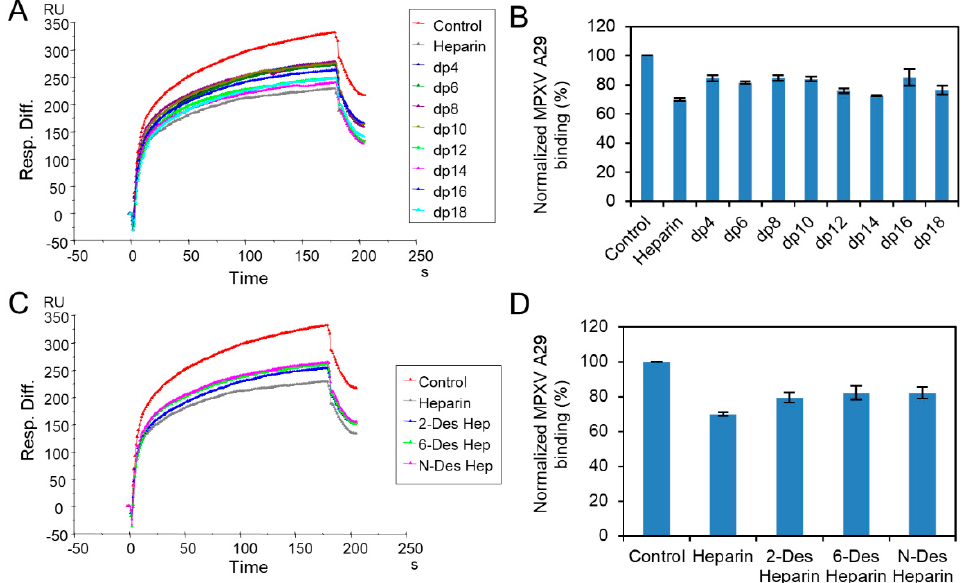
Figure 4. Solution competition between heparin and heparin oligosaccharides/desulfated heparins. ( A ) SPR sensorgrams of MPXV A29–heparin interaction competing with different oligo-heparins. Concentration of MPXV A29 is 250 nM mixed with 1000 nM of different oligo-heparins. ( B ) Bar graphs (based on triplicate experiments with standard deviation) of normalized MPXV A29 binding preference to surface heparin, by competing with different oligo-heparins. ( C ) SPR sensorgrams of MPXV A29–heparin interaction competing with different desulfated heparins. Concentration of MPXV A29 is 250 nM mixed with 1000 nM of different desulfated heparins. ( D ) Bar graphs (based on triplicate experiments with standard deviation) of normalized MPXV A29 binding preference to surface heparin, by competing with different desulfated